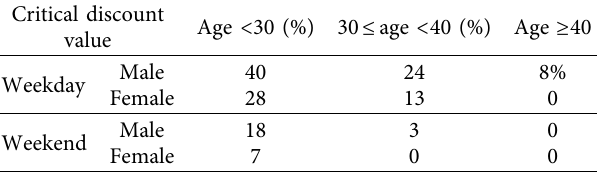
Table 7: Critical values of discount. Critical discount